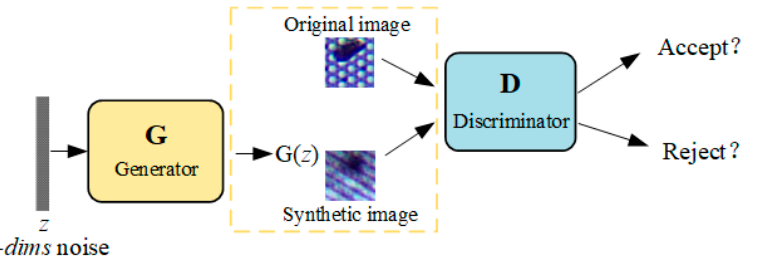
Figure 2. GAN diagram. Figure 2. GAN